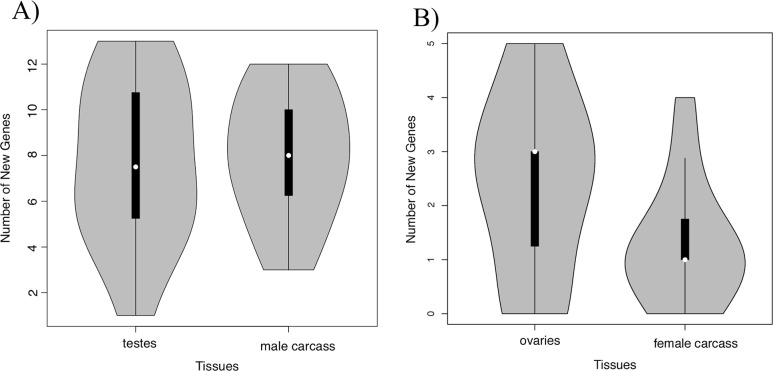
Distribution of new genes per strain identified in testes, male carcass, ovaries, and female carcass based on 14 inbred lines in males (A) and females (B). A total of 51 new genes were identified across all 14 strains in all tissues. We not see a difference in the number of new genes expressed between male gametic and somatic tissue (ANOVA, F(1,13) = 0.04, P>0.8). While there is a significant difference between ovaries and female tissue (ANOVA, F(1,13) = 4.379, P<0.05), the values are low for each line (including being 0 for multiple samples). This suggest that the male comparison is more indicative of the ratio between somatic and gametic tissue.